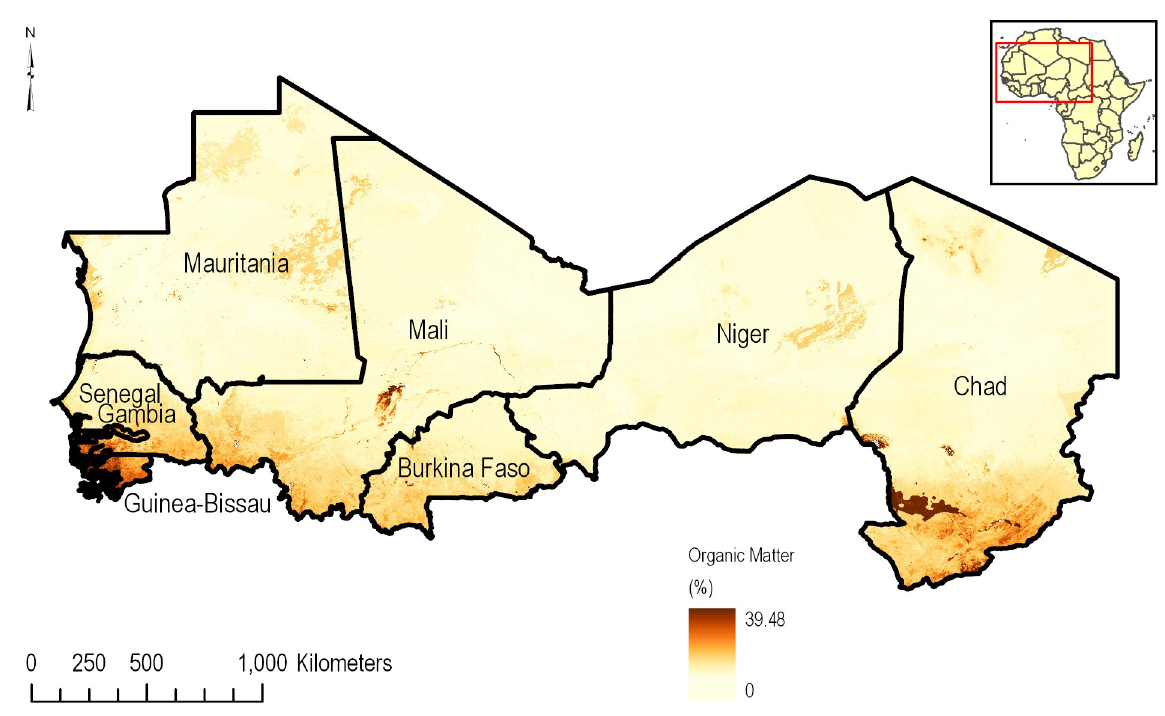
Fig 5. Distribution of topsoil (0–15 cm depth) organic carbon content in CILSS based on the SoilGrid [10] data.